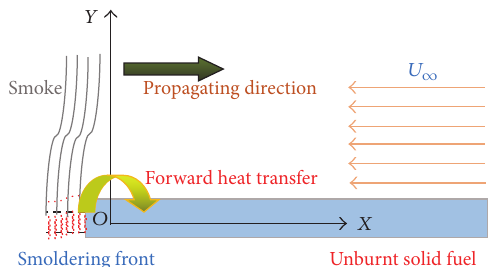
Figure 1: Schematic of smoldering combustion and forward heat transfer.